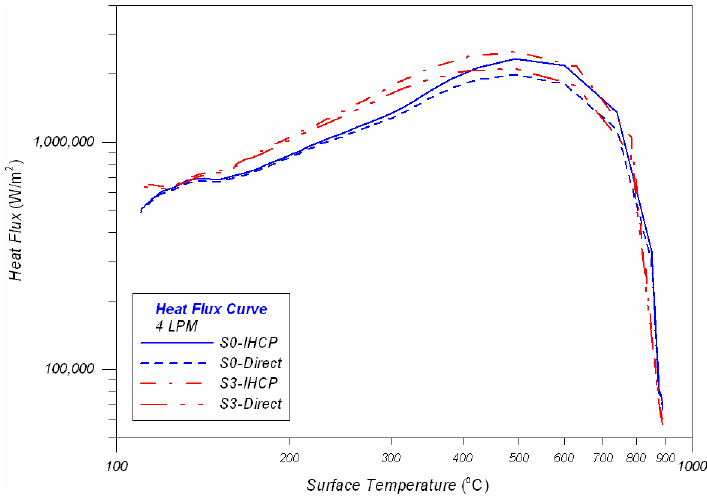
Fig. 9 Comparison of heat flux curve between IHCP and direct measurement at 4